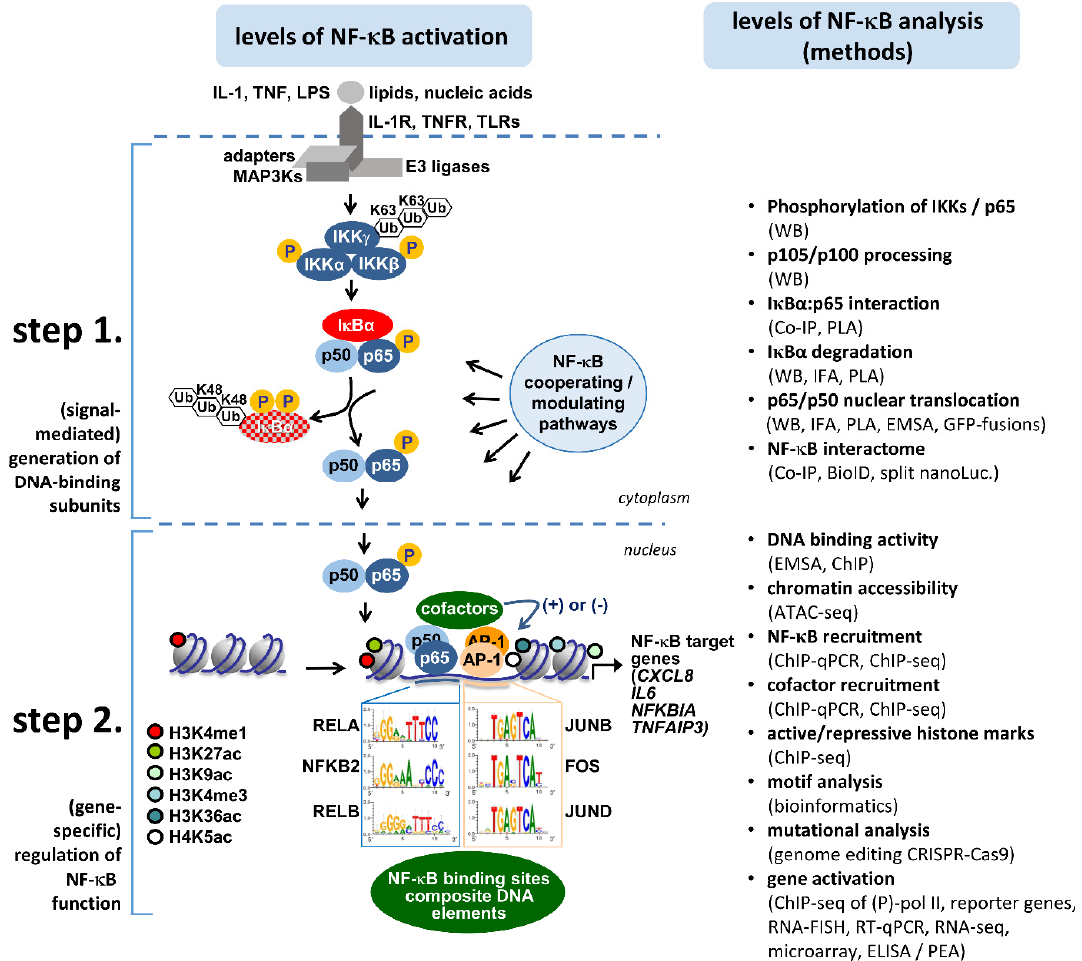
Figure 2. The two intracellular levels of NF ‐κ B activation and the approaches to determine NF ‐κ B activity. Overview of the core components and features of the canonical NF ‐κ B pathway, its two regulation levels in the cytosol (step 1) and the nucleus (step 2), and the approaches and methods available to assess the NF ‐κ B activation state. For details, see text.